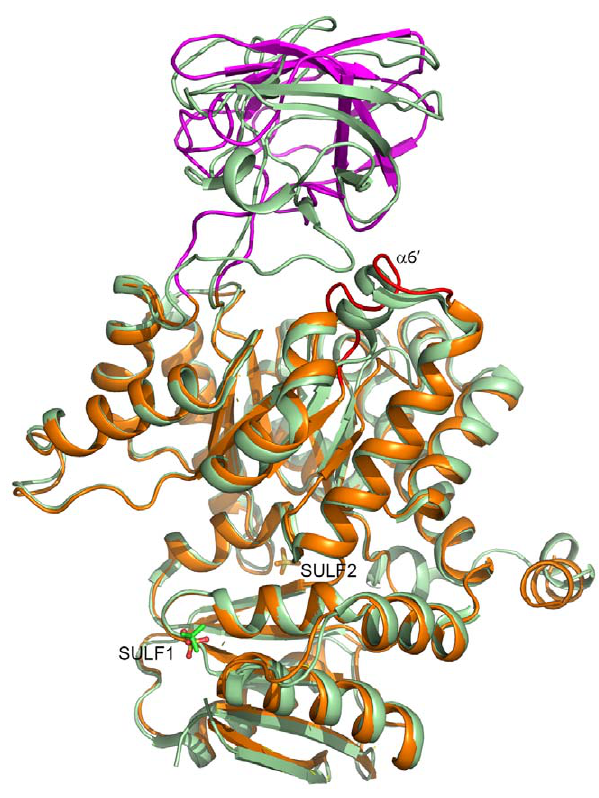
Figure 7. Cartoon drawing showing superposition of C.parvum pyruvate kinase structures. Our structure is orange, except for the B domain, which is magenta; 3MA8 is light green. Sulfate ions are shown as stick models (our structure - yellow and red; 3MA8 - green). The a 6’ helix in our structure is highlighted in red.